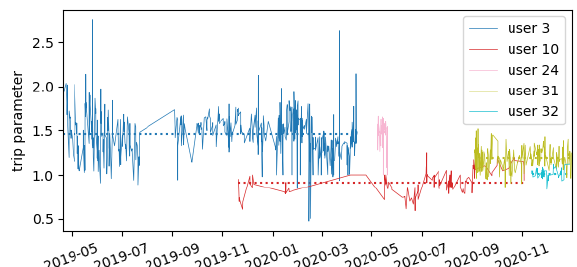
Figure 7. Plot of estimated trip parameters over time. They are colored by user and include the median as dashed line. User 3, 24 and 31 rode sporty track bikes with high tire pressures and users 10 and 32 city bikes.